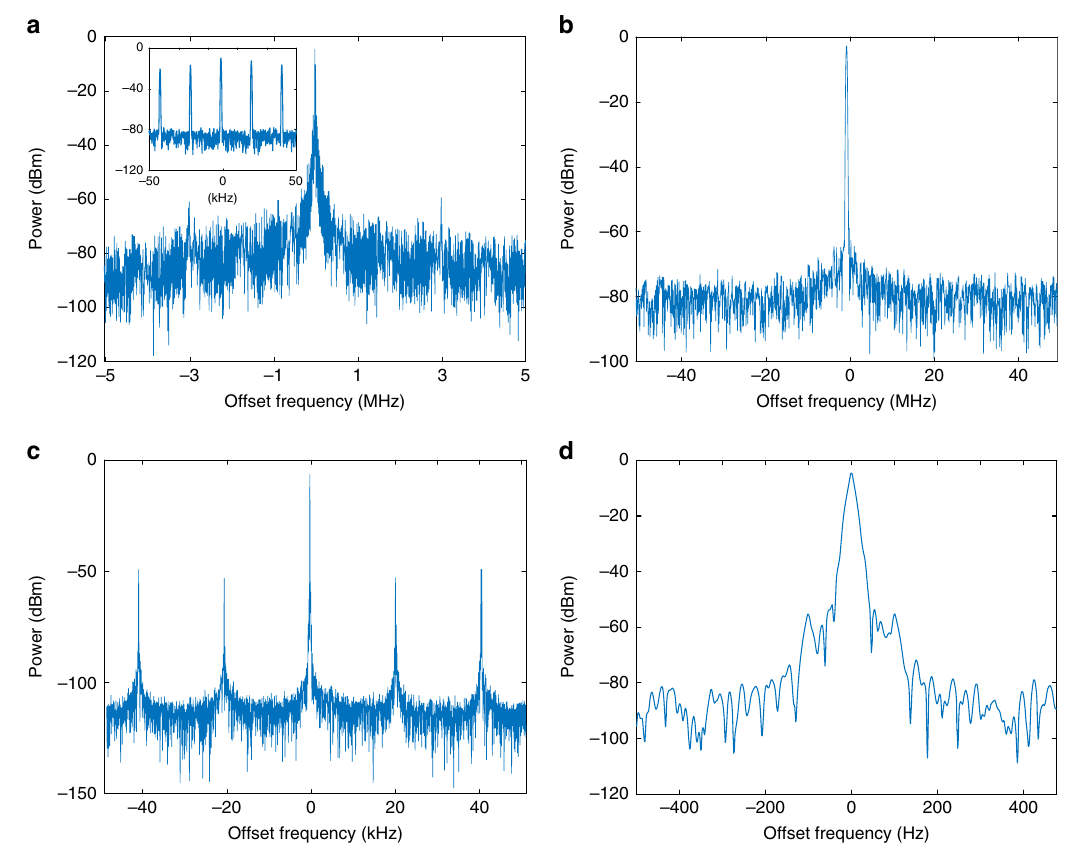
Fig. 4 The electrical spectra of the microwave signals generated by the wavelength-space PT-symmetric OEO. The spectra are measured at a central frequency at 10 GHz. a Multimode oscillation spectrum measured by an ESA with a resolution bandwidth (RBW) of 3 MHz. Inset: zoom-in view of the multimode spectrum showing multiple modes with comparable amplitudes; single-mode oscillation spectra measured with RBWs of b 3 MHz, c 100 kHz and d 9 Hz. The spectrum in ( c ) shows a dominating mode with a sidemode suppression ration of 46.75 dB.